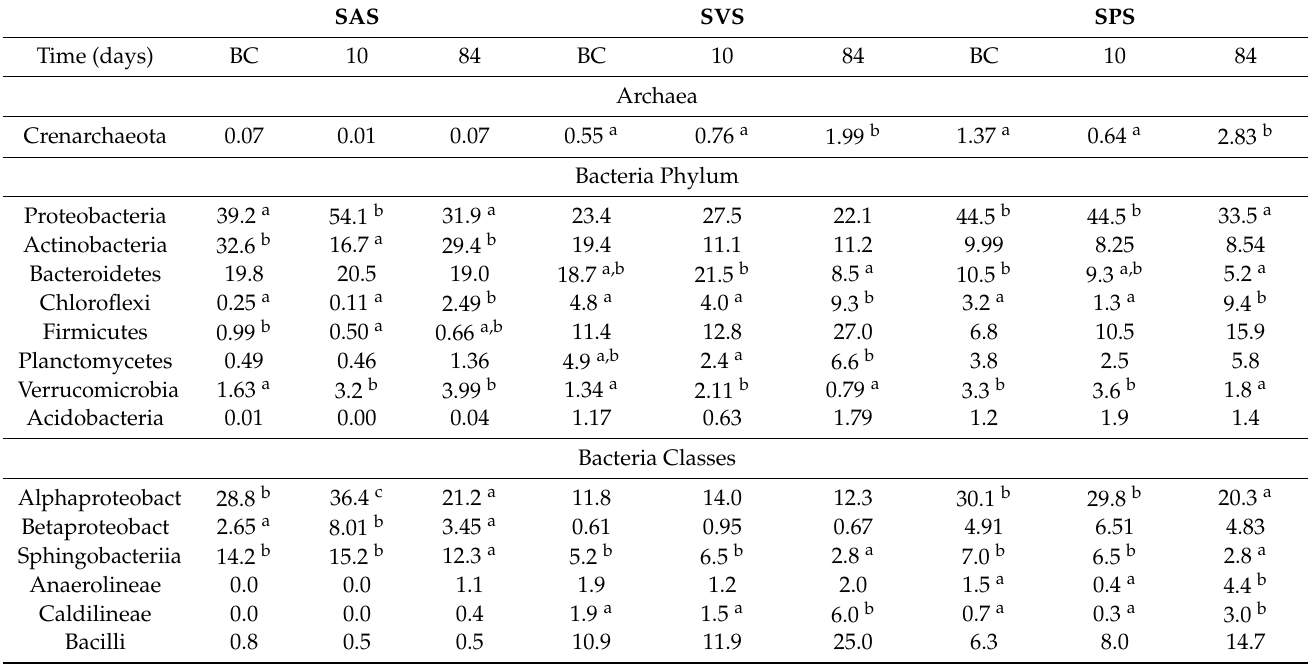
Table 4. Percentages of the relative abundance of bacterial phyla and bacterial classes in the biopurification systems assayed before contamination (BC) and at 10 and 84 days after the addition of the